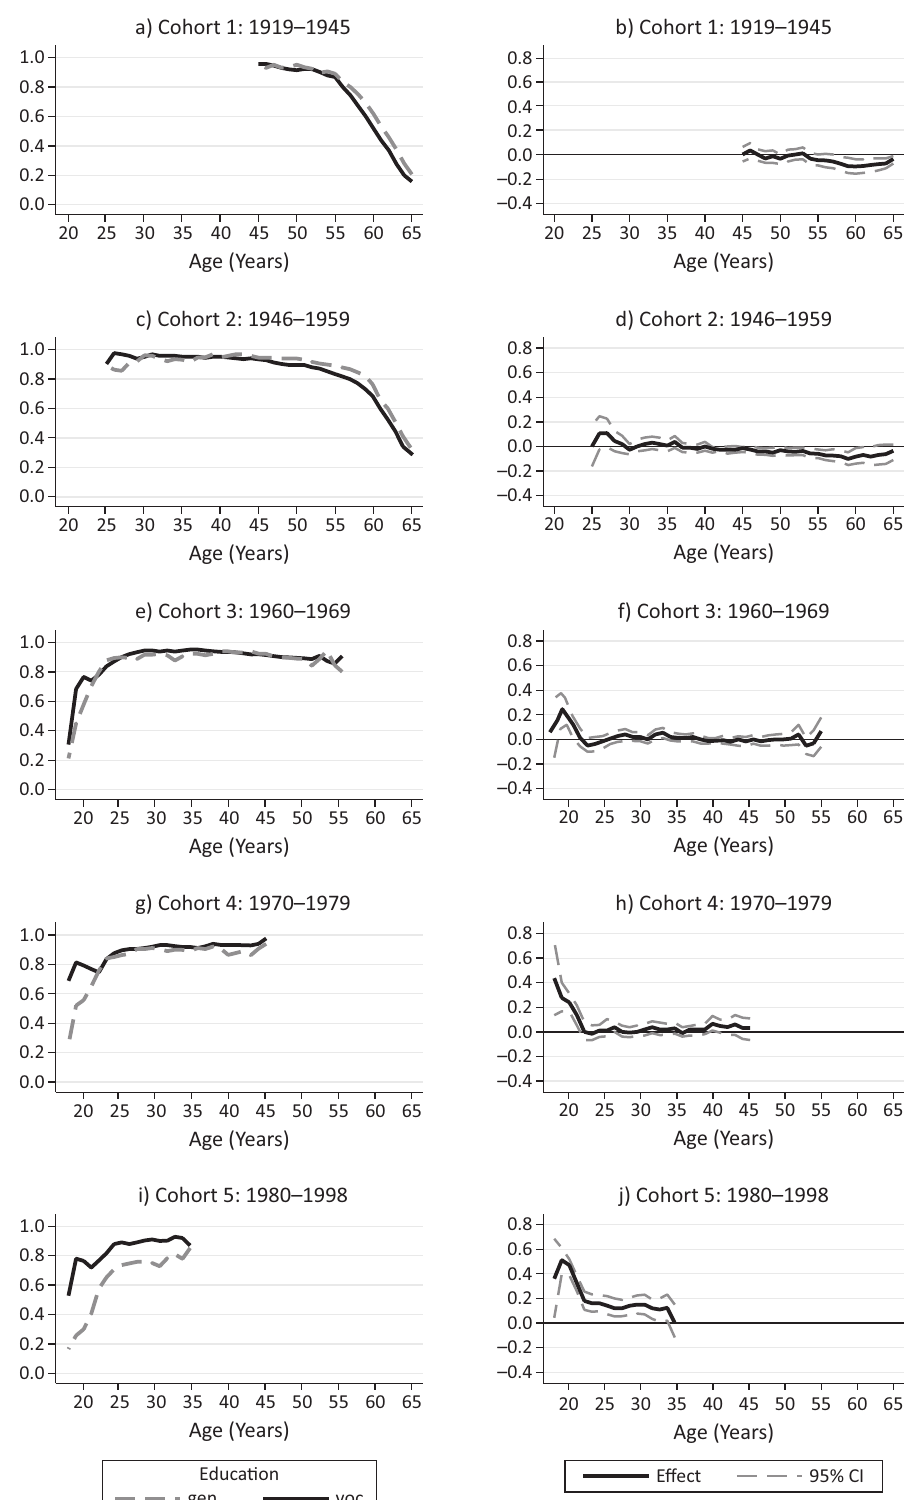
Figure 5. Cohort variation in employment opportunity over the life course: General versus vocational education (men). Notes: Conditional profile plots (left) and conditional effect plots (right) estimated by cohort-specific non-parametric state probability models of vocational and general education on employment probabilities of men. Control variables include period effects, German nationality, parental educational background, residence in West Germany, and educational level. N persons (cohort 1) = 3,232; N person-years (cohort 1) = 28,299; N persons (cohort 2) = 4,778; N person-years